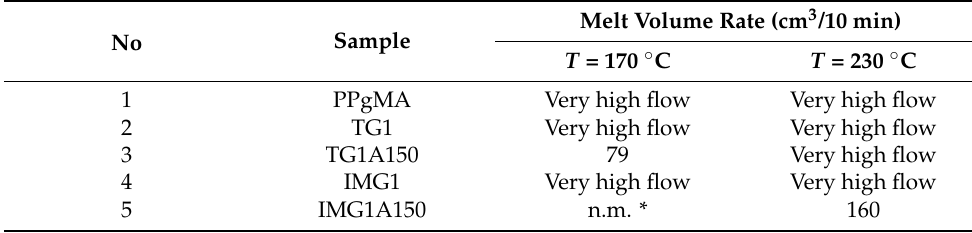
Table 4. Melt Volume Rate of PPgMA and its cross-linked products.